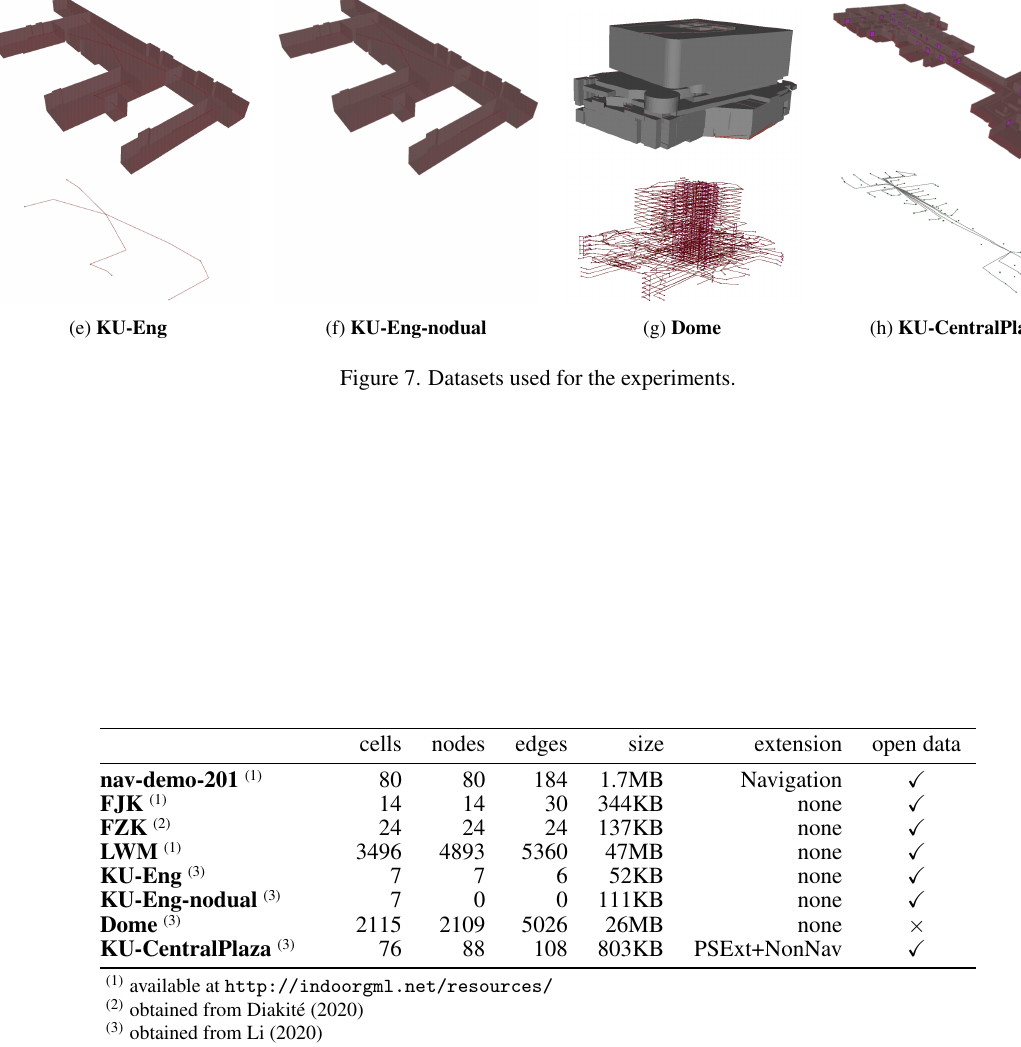
Table 1. Datasets used for the experiments (see Figure